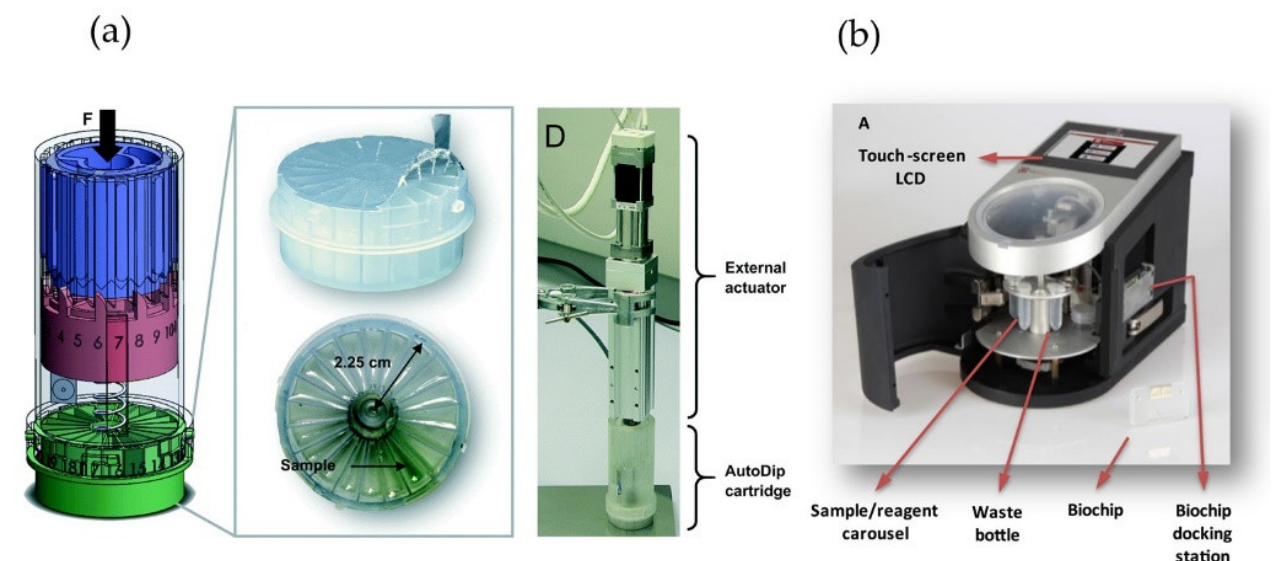
Figure 6. Examples of microfluidic chip-based electrochemical food analyzers. ( a ) AutoDip design and evaluation model. The reagent module is pre-filled with reagents, while an external vertical actuator is controlling the incubation and washing steps by consecutive dipping of the electrode into the reagents. Reproduced with permission from [102] lab on a chip, Copyright (2015), under Royal Society of Chemistry; ( b ) MiSense device designed for rapid and reliable detection of aflatoxin B1. The biochip attachment to the docking station creates a microfluidic channel on the top of the electrodes. Reproduced from [104] Talanta, Copyright (2016), with permission from Elsevier.